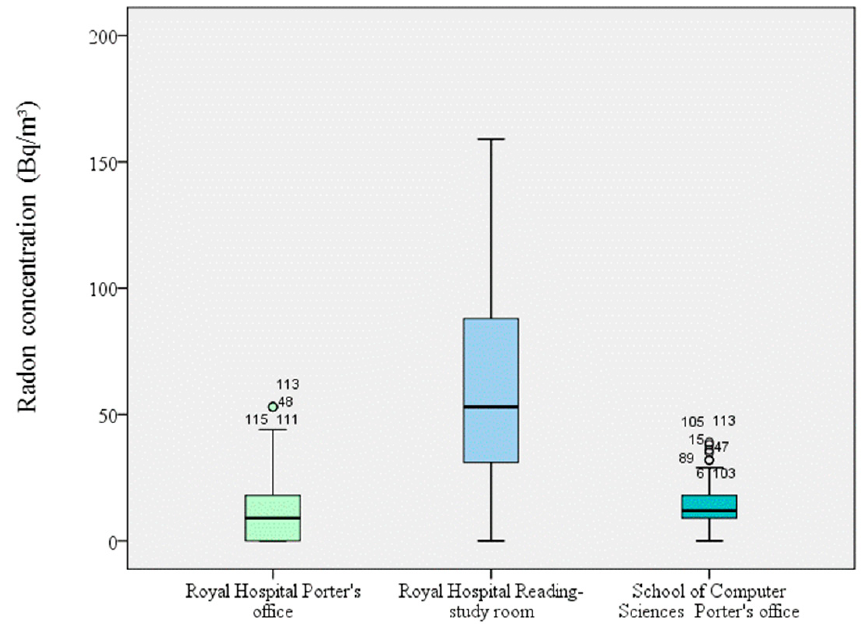
Figure 2. Radon in indoor air in 15th century (Royal Hospital) and 21st century (School Computer Sciences) buildings.